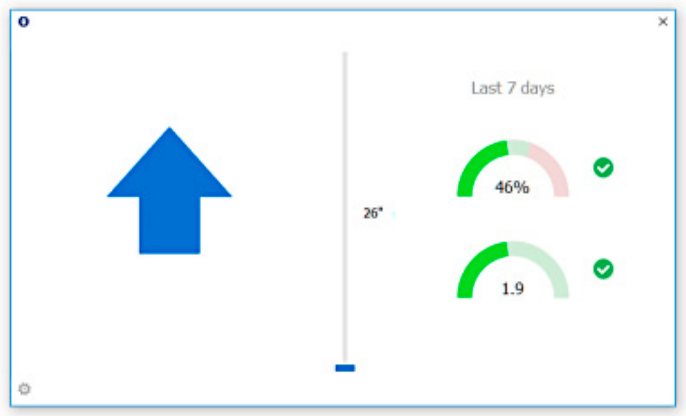
Figure 2. Screenshot of the software prompt where workers could interact with their personal